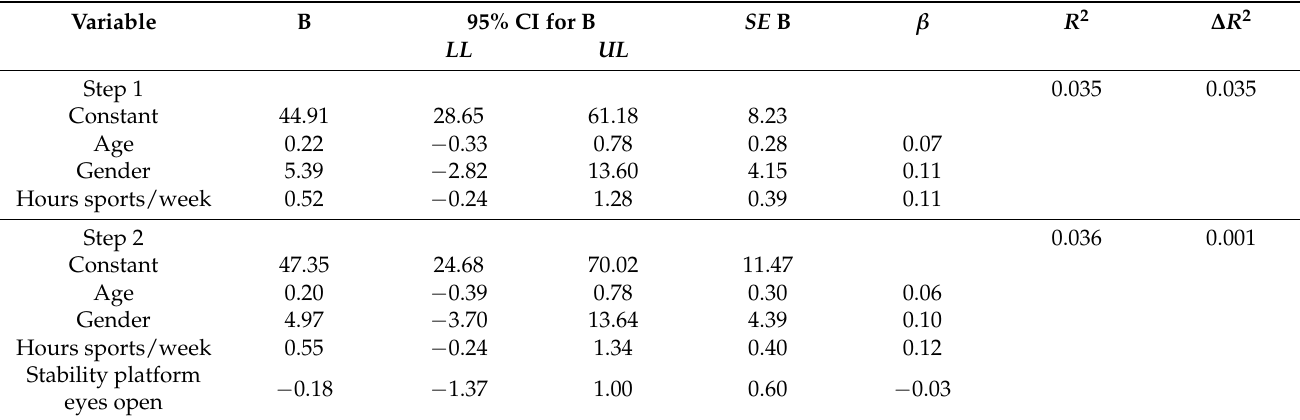
Table 3. Hierarchical regression model for the flanker effect (RT incongruent–RT